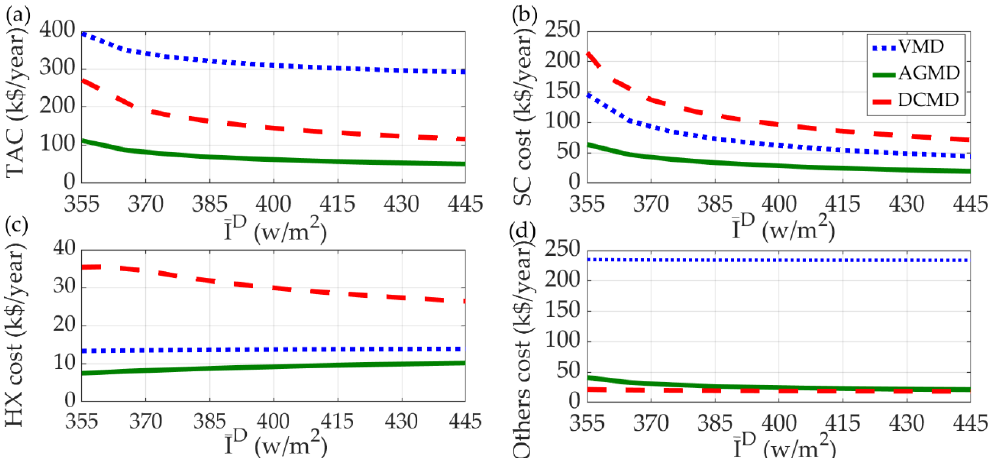
Figure 6. Optimal solutions of solar-driven AGMD, DCMD, and VMD systems for desalination from the first design stage for different constant-value solar radiation intensity, ( a ) TAC, ( b ) solar collector cost, ( c ) heat exchanger cost, ( d ) cost of all other units.